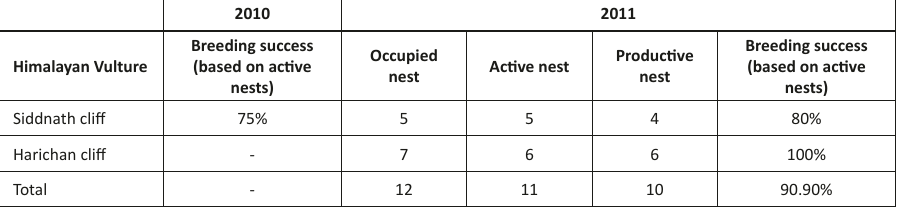
Table 2. Breeding success of Himalayan Vultures in two different cliffs of Khodpe, Far-west Nepal. Breeding success of Himalayan Vulture in 2010 in Siddnath cliff only (no record in Harichan Cliff) by Karmacharya (2011) is also shown in the